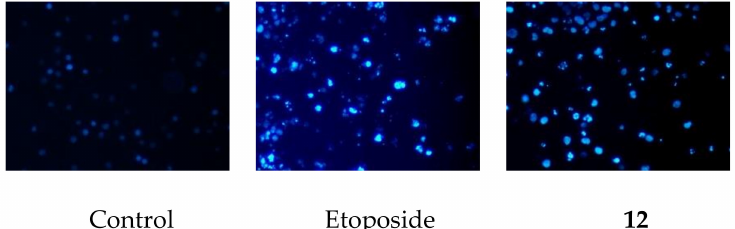
Figure 3. Morphology of HL-60 cells treated with either etoposide or 12 . HL-60 cells were incubated with either etoposide (17 µ M) or 12 (20 µ M) for 72 h, stained with DAPI and observed under a fluorescence microscope (magnification, 200 ×